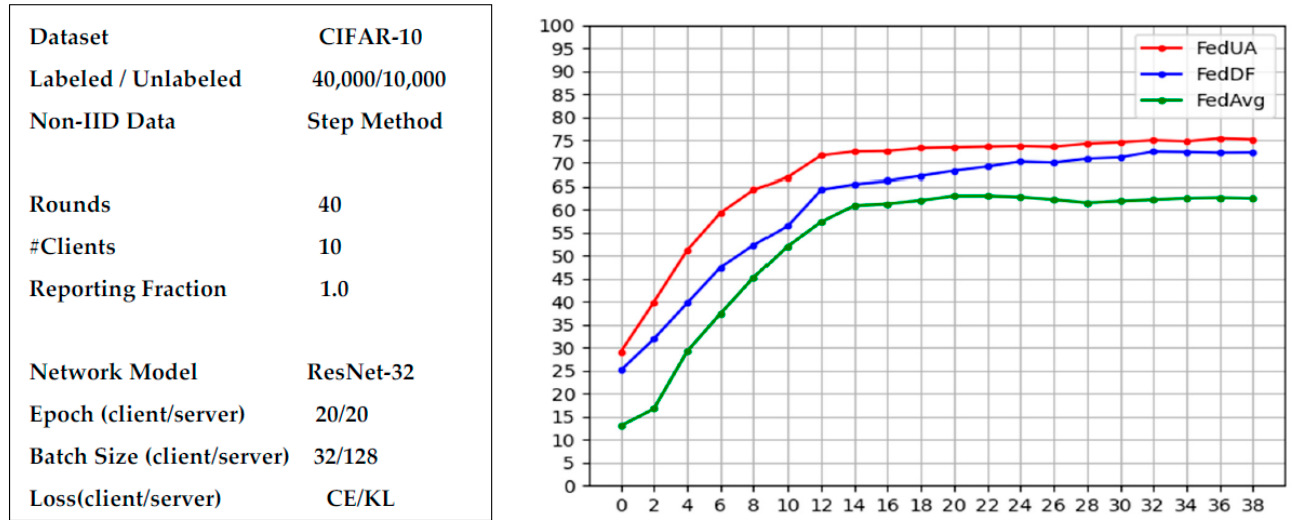
Figure 13. The learning curves of FedUA, FedDF, and FedAvg (horizontal-axis: the round number and vertical-axis: the accuracy percentage).